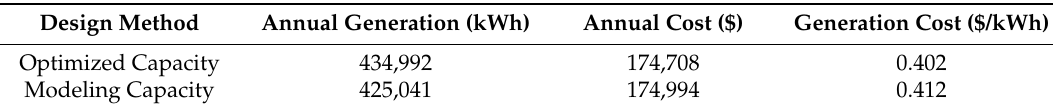
Table 13. Economic comparison of operation cost between optimized capacity by real load pattern and modeling one using estimated load pattern for Island 7.